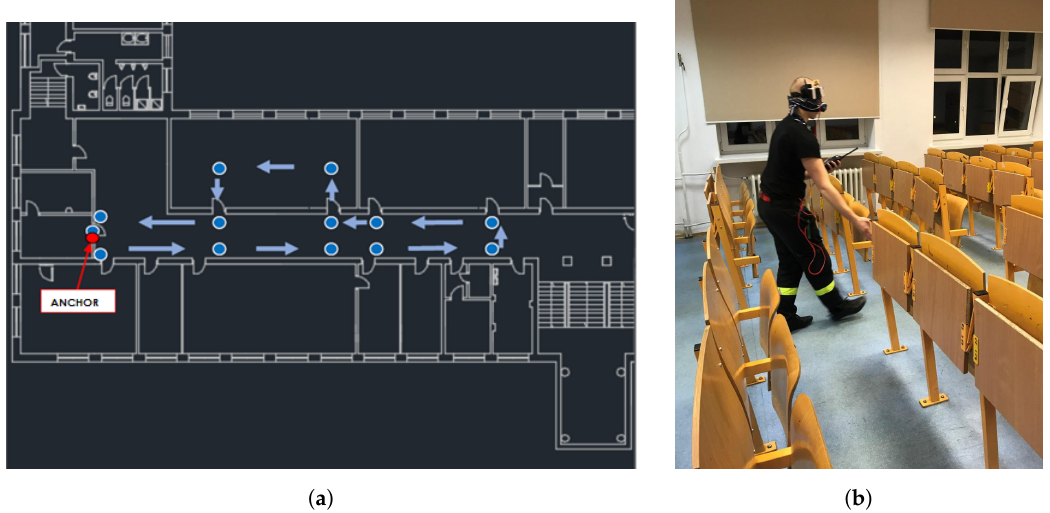
Figure 10. Test III. ( a ) Marked stop points for the path in Test III; ( b ) The movement across the furnished compartment during Test